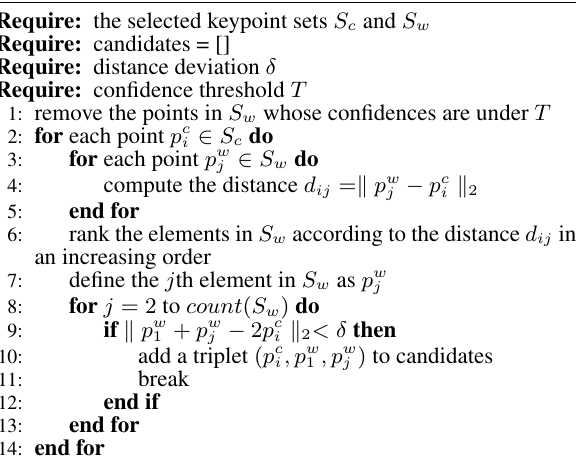
Algorithm 1 Side Keypoint Clustering Algorithm.